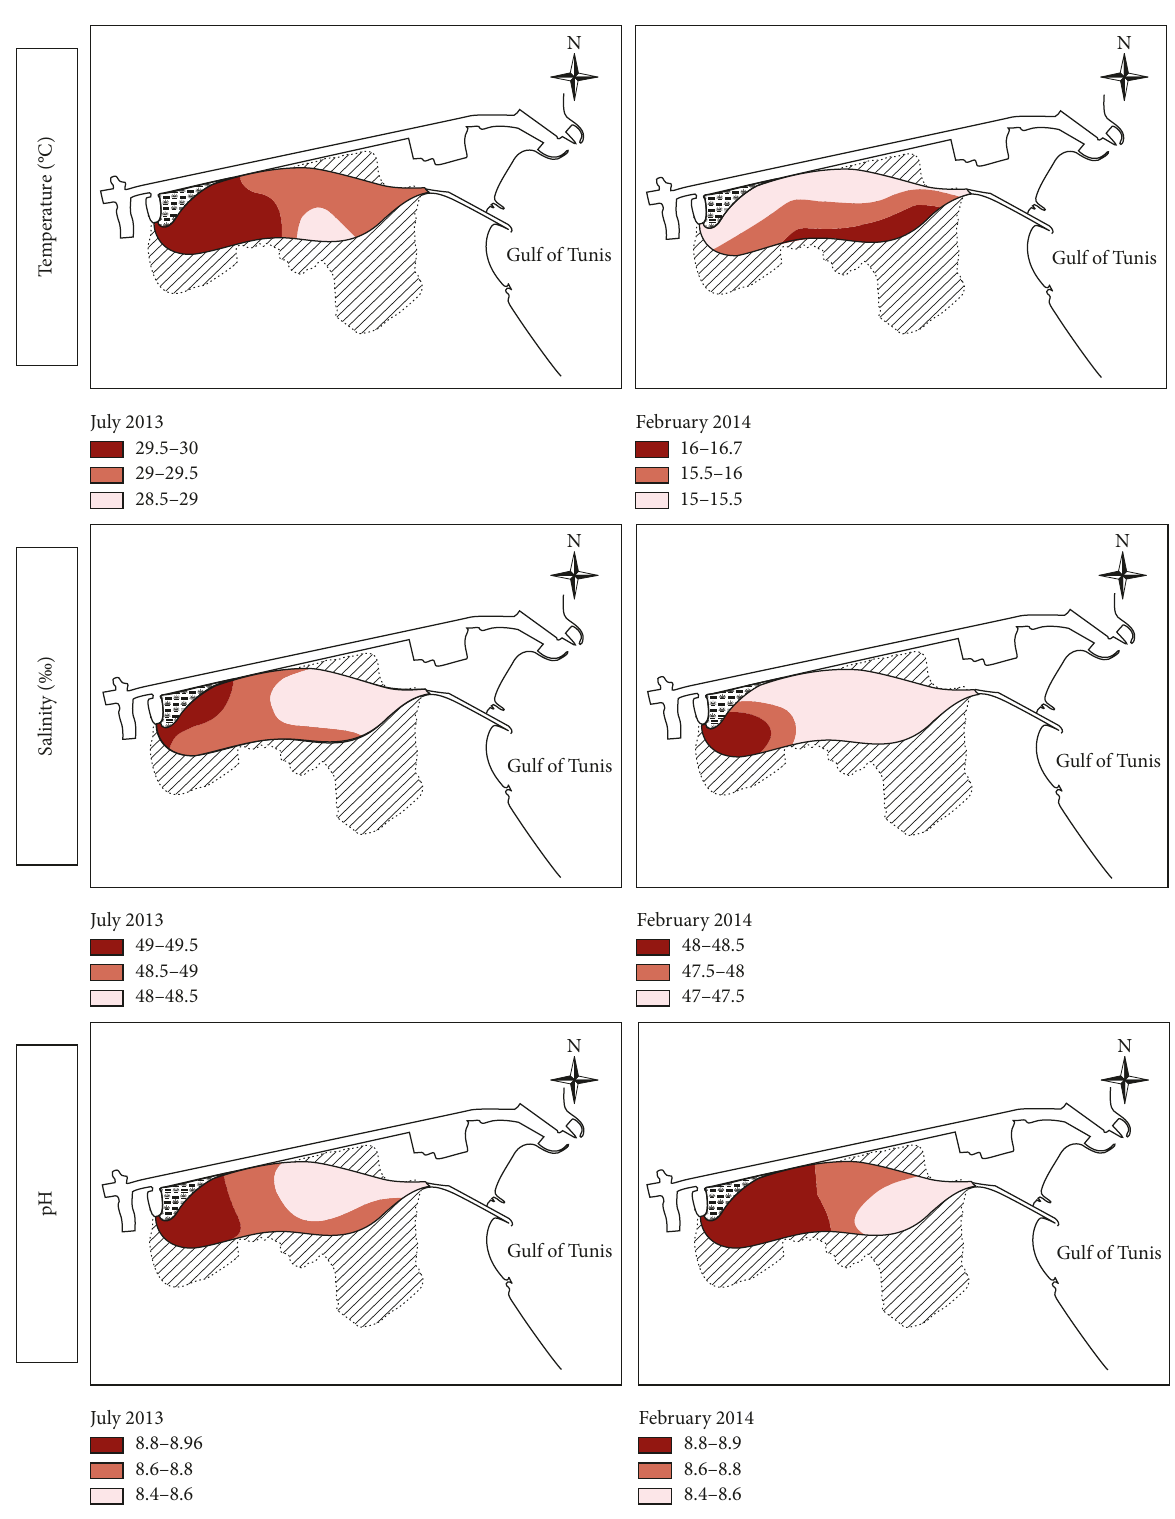
Figure 4: Physicochemical distribution maps of the South Lagoon of